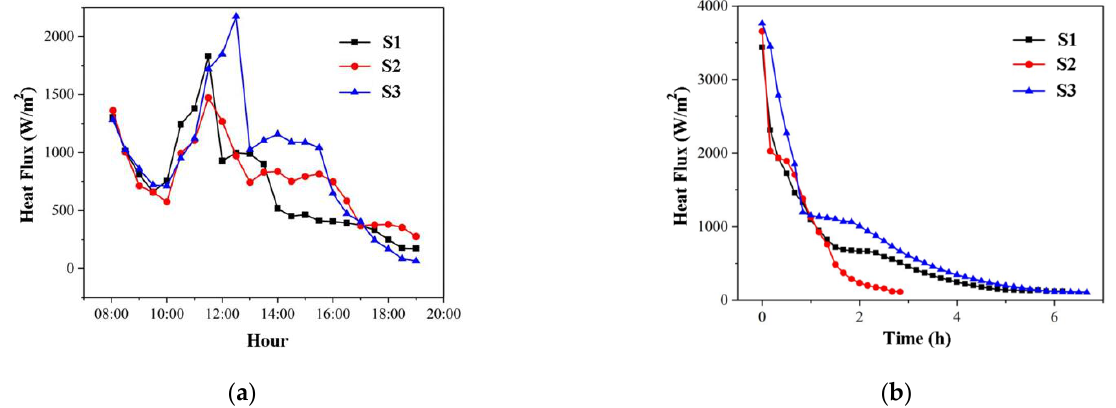
Figure 9. Average heat flux in the cascade units of S1 – S3: ( a ) heat storage process; ( b ) heat release process.